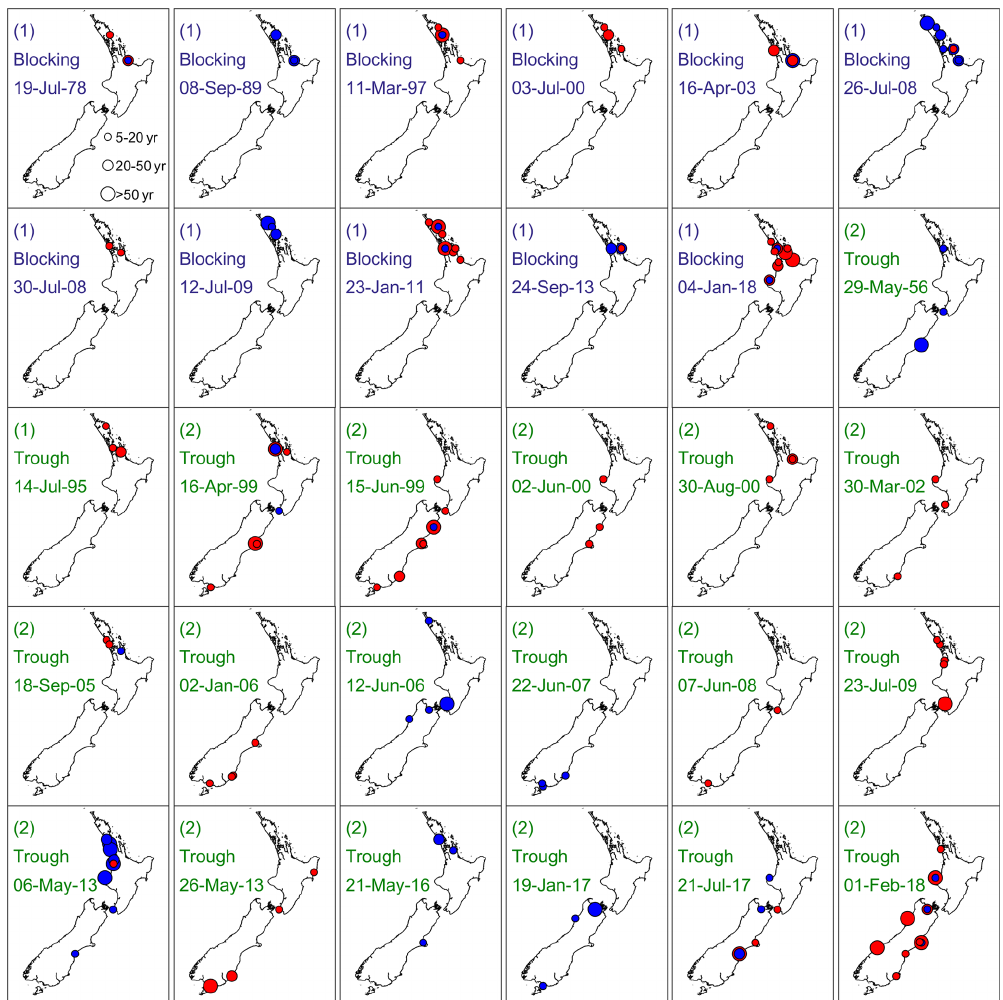
Figure 5. The spatial footprints of all the storm-tide or skew-surge events that impacted at least three tide gauge sites. Red circle denotes extreme storm tide; blue circle denotes extreme skew surge. Circle diameter matched to return periods of 5–20, 20–50 and ≥ 50 years (small to large respectively). The spatial cluster category (1 or 2), Kidson weather type and date during each event are